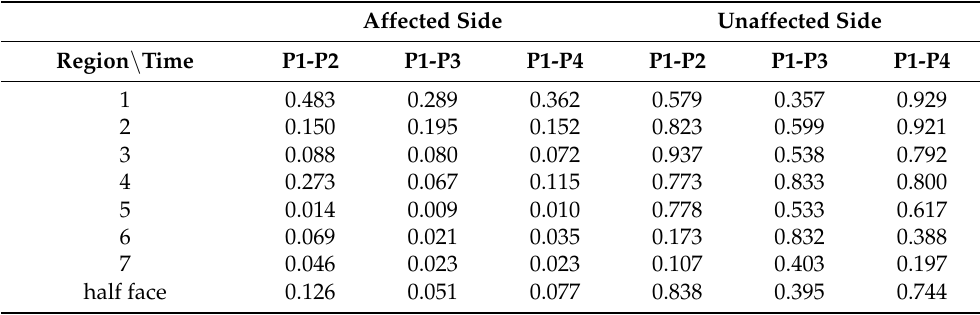
pre-PMS and post-PMS intervention (Figure 4). Table 4. The statistical differences of the facial skin blood flow between pre-PMS and post-PMS intervention in stroke patients with facial paralysis. P1, 0–5 min before the PMS intervention; P2, 0–5 min after the PMS intervention; P3, 6–10 min after the PMS intervention; P4, 0–10 min after the PMS